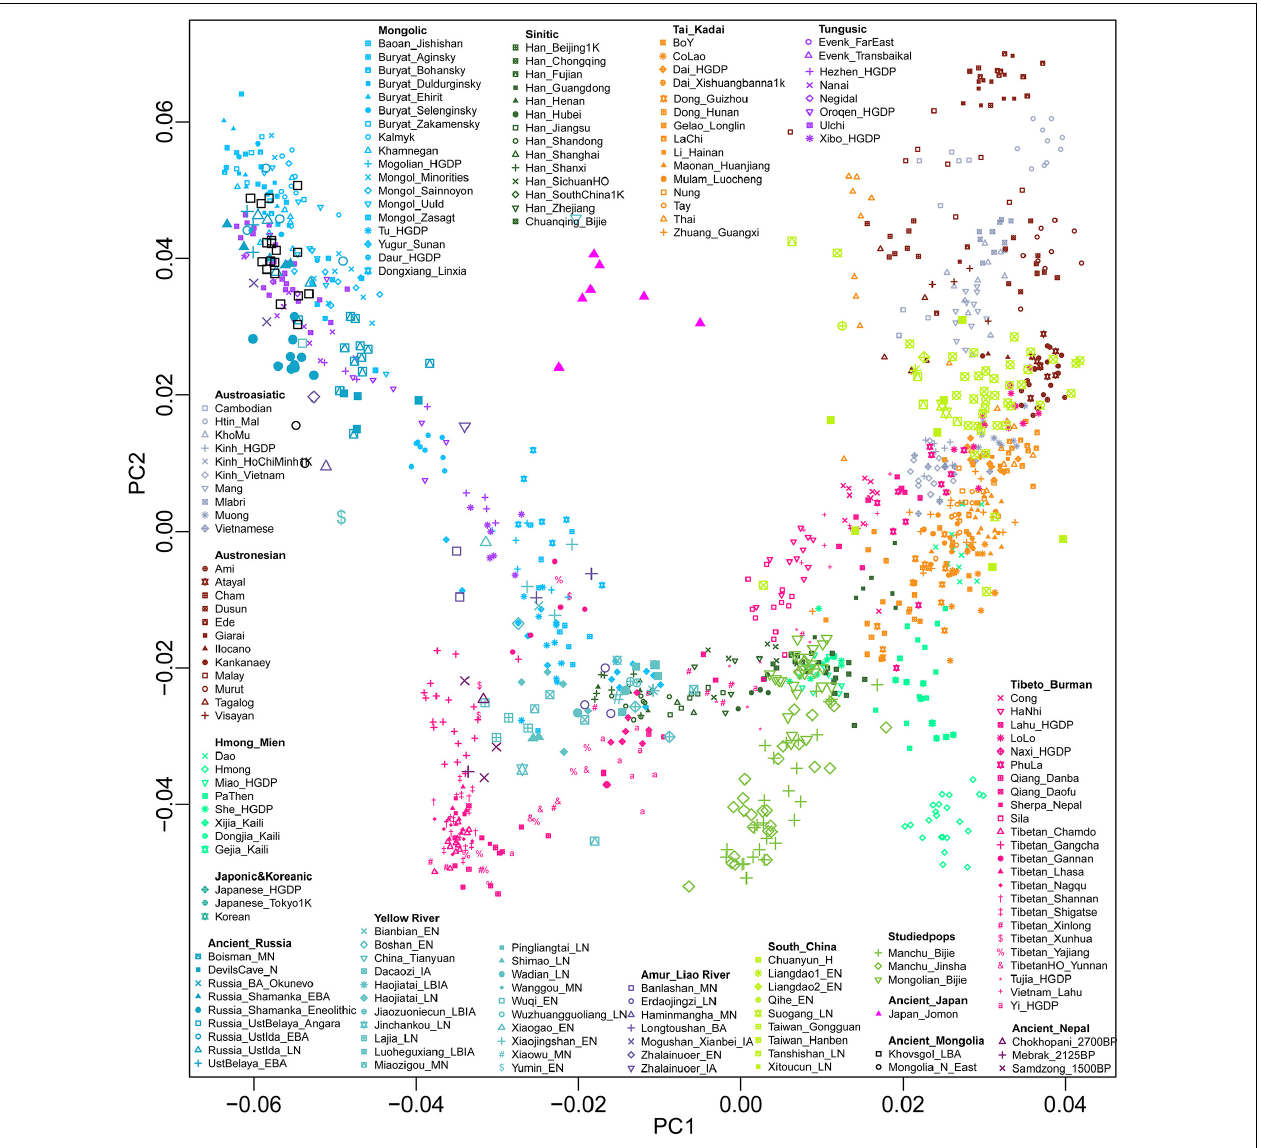
FIGURE 1 | Patterns of genetic relationship among East Asian populations inferred from principal component analysis. Genetic background was constructed based on the genetic variations from modern populations and their top two components. Modern populations were color-coded on the basis of their language family categories. All ancient populations were projected onto